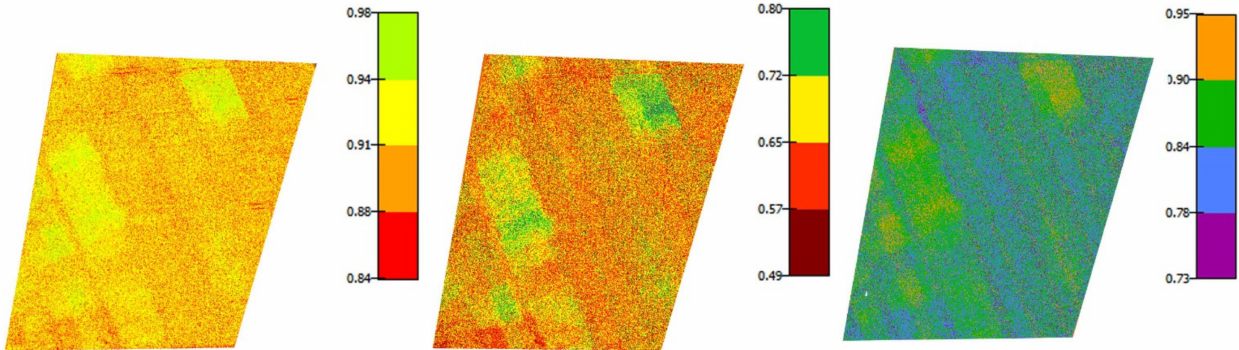
Figure 5. The maps of the investigated land at the fifth stage of scanning: (from left to right) the NDVI, NDRE, and GNDVI